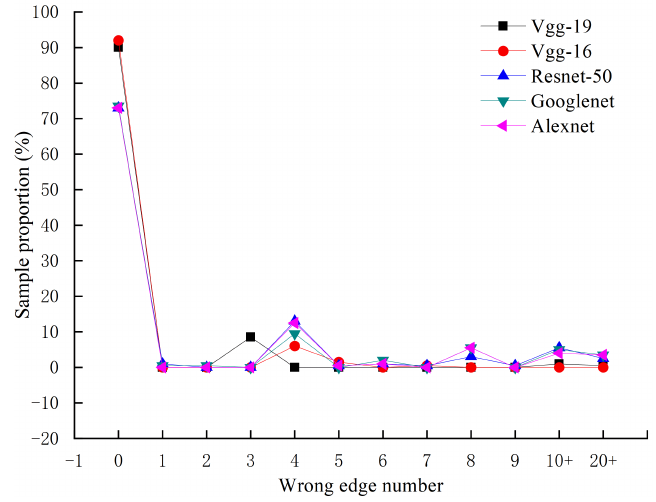
Figure 17. The performance of the correction algorithm in edge images.